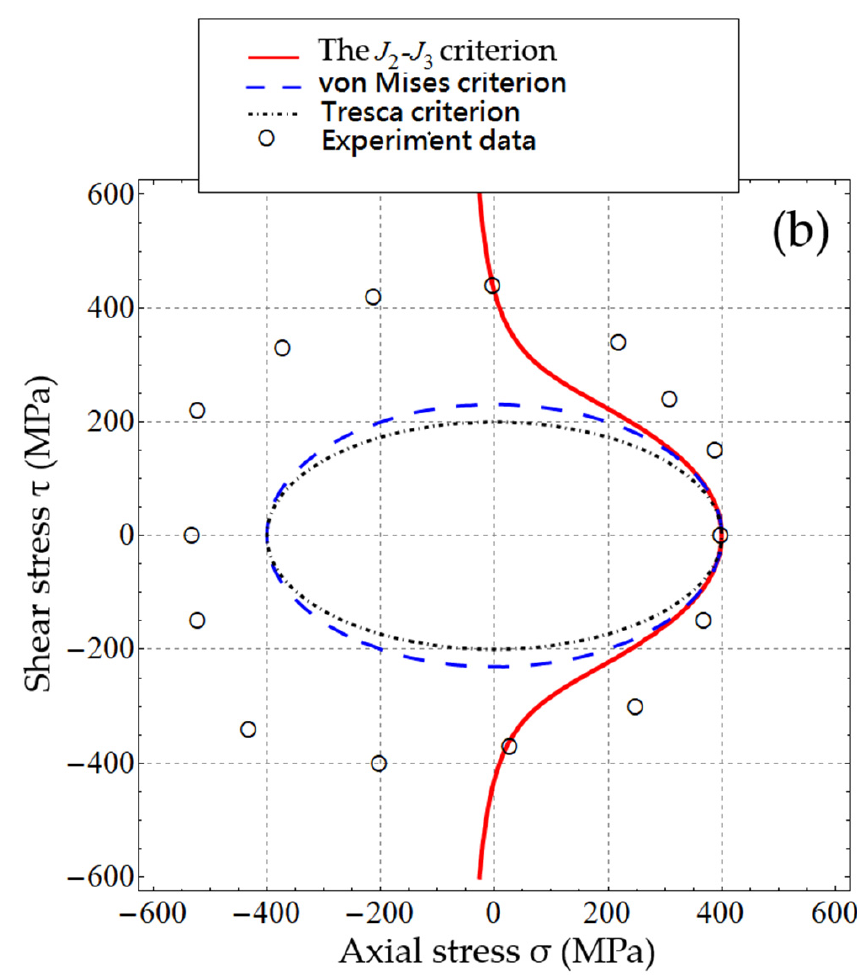
Figure 5. Comparison of experimental results and the theoretical initial transformation onset sur- faces for Ni–Ti SMA in the ( σ , τ ) plane predicted by the 2 3 J J - criterion, the Tresca criterion and the von Mises criterion: ( a ) calibrated by